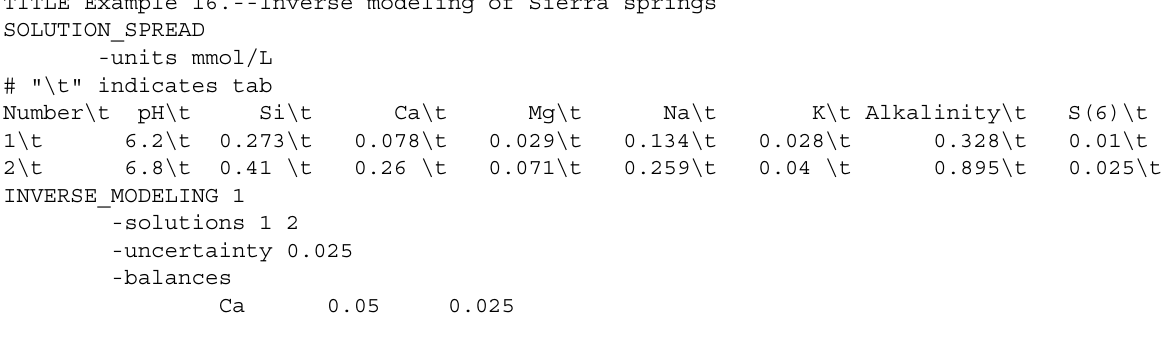
Table 47. Input file for example